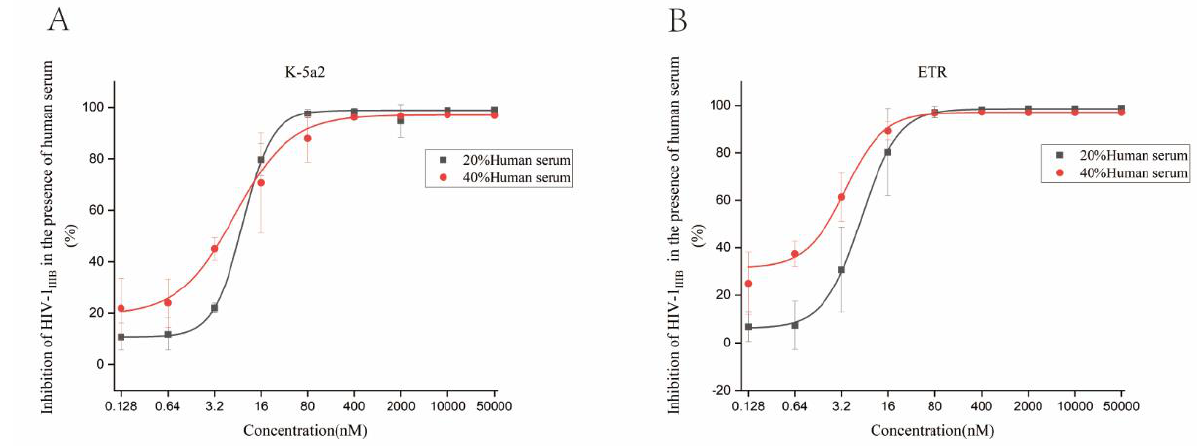
Figure 5. Antiviral properties of K-5a2 ( A ) and ETR ( B ) in the presence of human serum. C8166 cells infected by HIV-1 IIIB were treated with various concentrations of compounds in the presence of 20% or 40% human serum. After incubation for three days, the percentage inhibition of p24 was measured by ELISA assay.